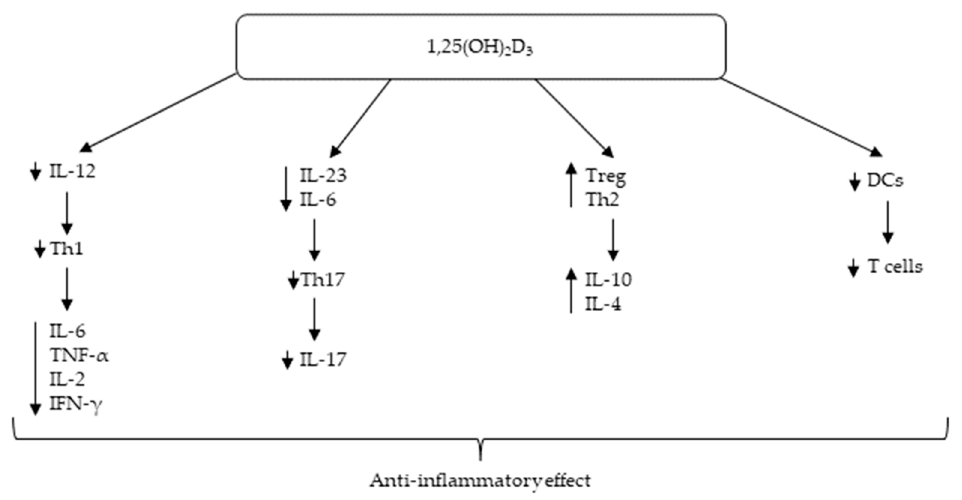
Figure 1. Immunomodulatory effect of vitamin D. Abbreviations: 1,25(OH) 2 D 3 —1,25- dihydroxyvitamin D 3 , DCs—dendritic cells, IFN- γ —interferon γ , IL-2—interleukin, IL-4—interleukin 4, IL-6—interleukin 6, IL-10—interleukin 10, IL-12—interleukin 12, IL-17—interleukin 17, IL-23— interleukin 23, TNF- α —tumor necrosis factor α , Th1—T helper cell 1, Th2—T helper cell 2, Th17—T helper cell 17, Treg—T regulatory